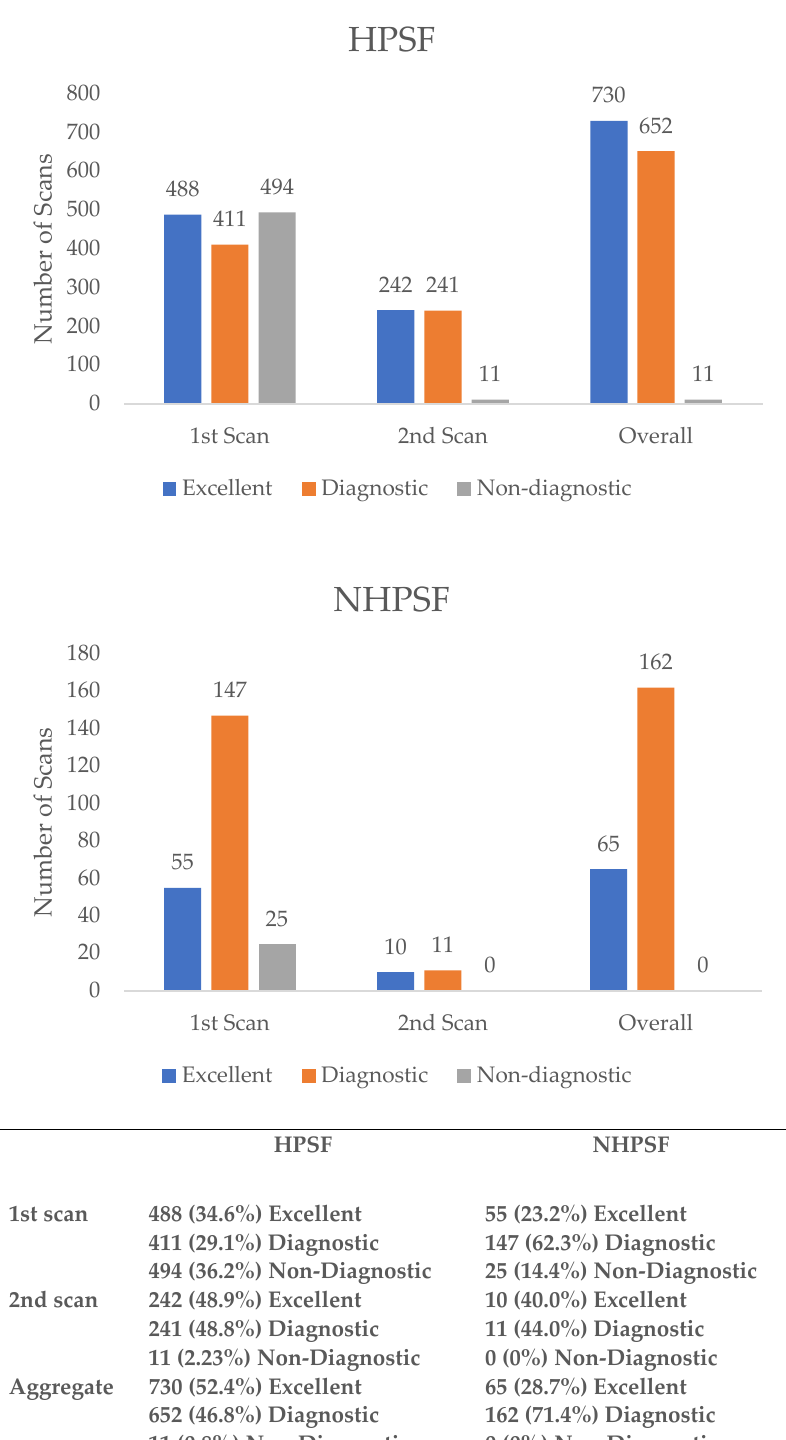
Figure 4. Image quality of the first and repeat scans for patients with a HPSF and NHPSF approach. HPSF: high-pitch spiral first; NHPSF: non-high-pitch spiral first.